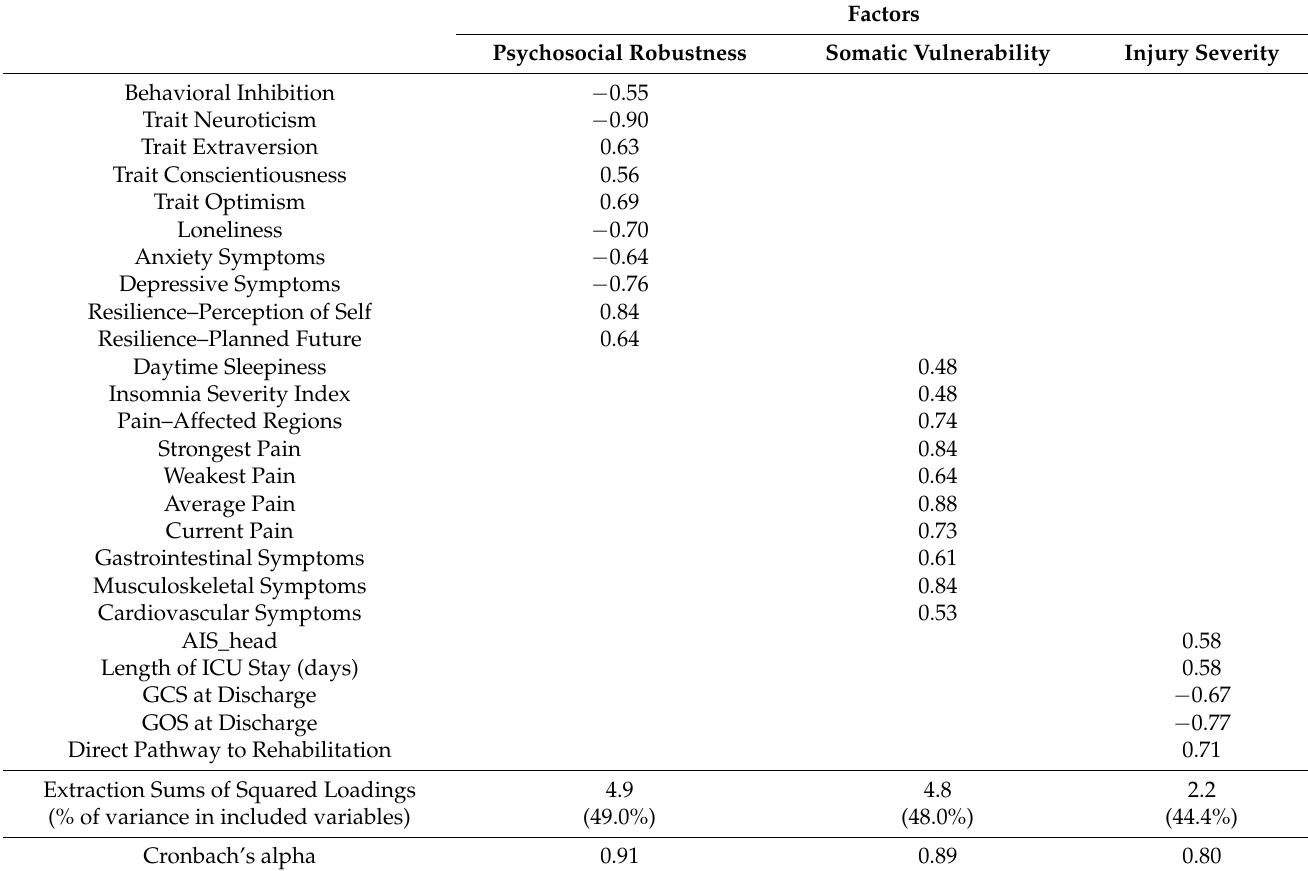
Table 2. Factor loadings for the final unidimensional factor analyses of self-reported independent variables (N = 96). Squared loadings and explained variance therefore refer to only those variables included in each of the three factor analyses. For an overview of the primary factor analyses, see the Supplementary Materials (Table